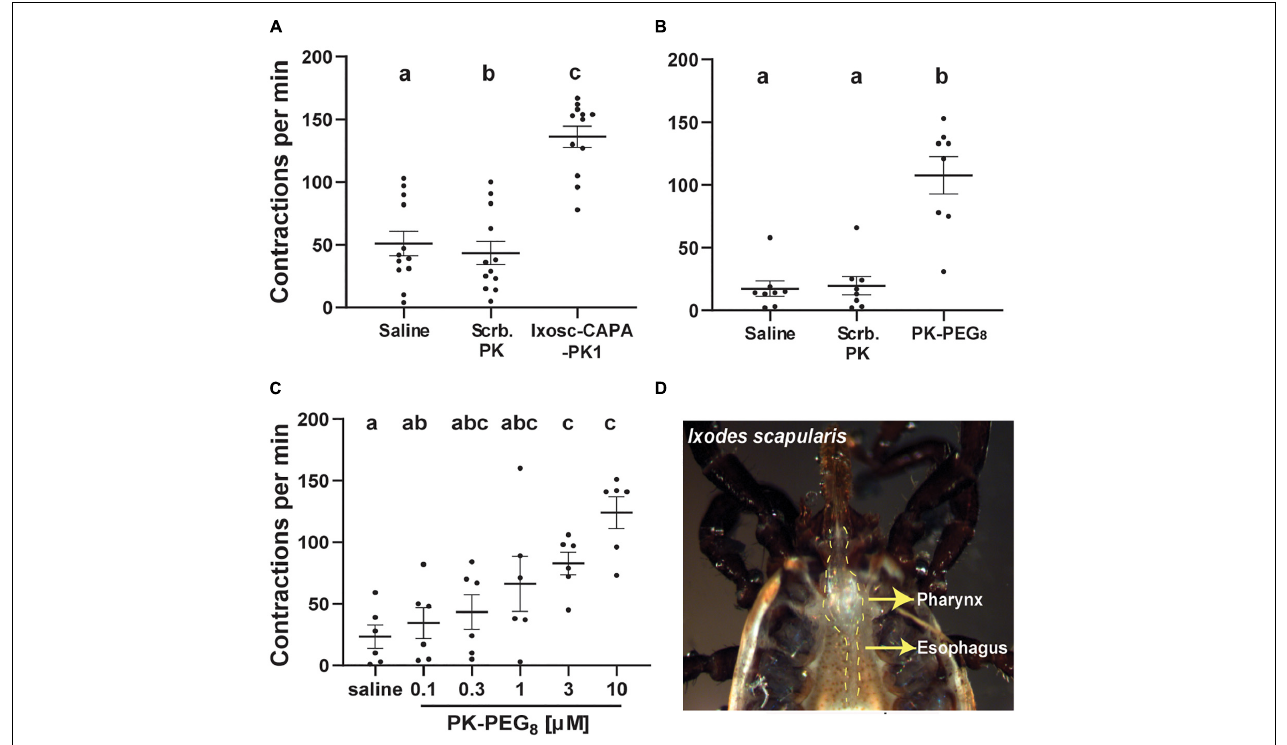
FIGURE 5 | Ixodes scapularis feeding tissue contraction assay. (A) Activity of the tick endogenous Ixosc-CAPA-PK1 (RSNNFTPRIa) (B) and PK-PEG 8 (MS[PEG 8 ]-YFTPRLa). In (A) , the PK and in (B) , the PK analog increase the contractions of the pharynx-esophagus: After dissection, ticks were transferred to a Sylgard plate into fresh saline (100 µ l). After 5 min of adaptation to the environment, the solution was replaced with 100 µ l of saline, and tissues were filmed